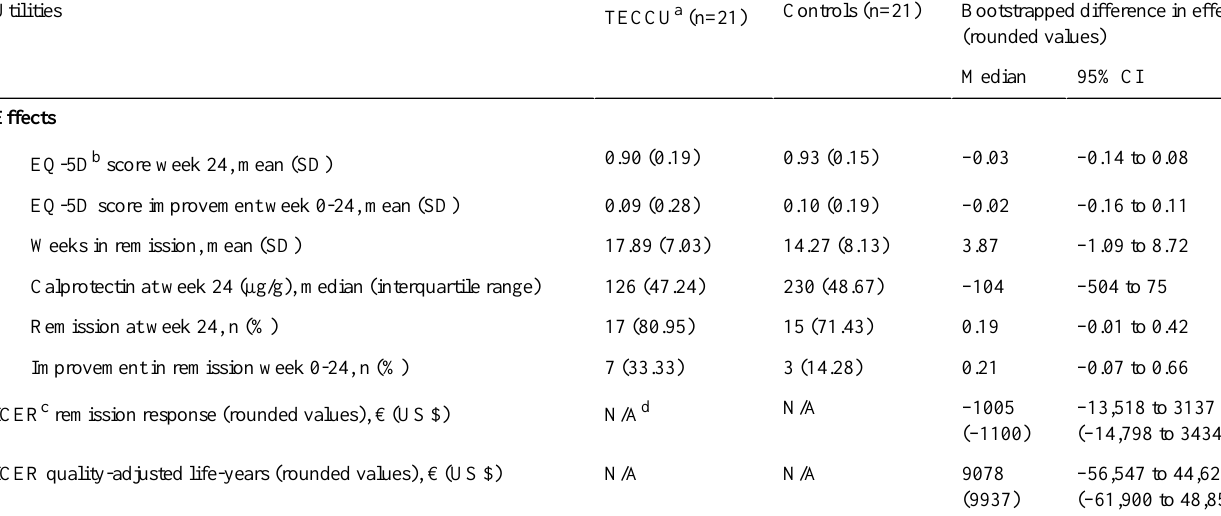
Table 4. Utilities per patient in the group receiving remote monitoring (G_TECCU) vs standard care